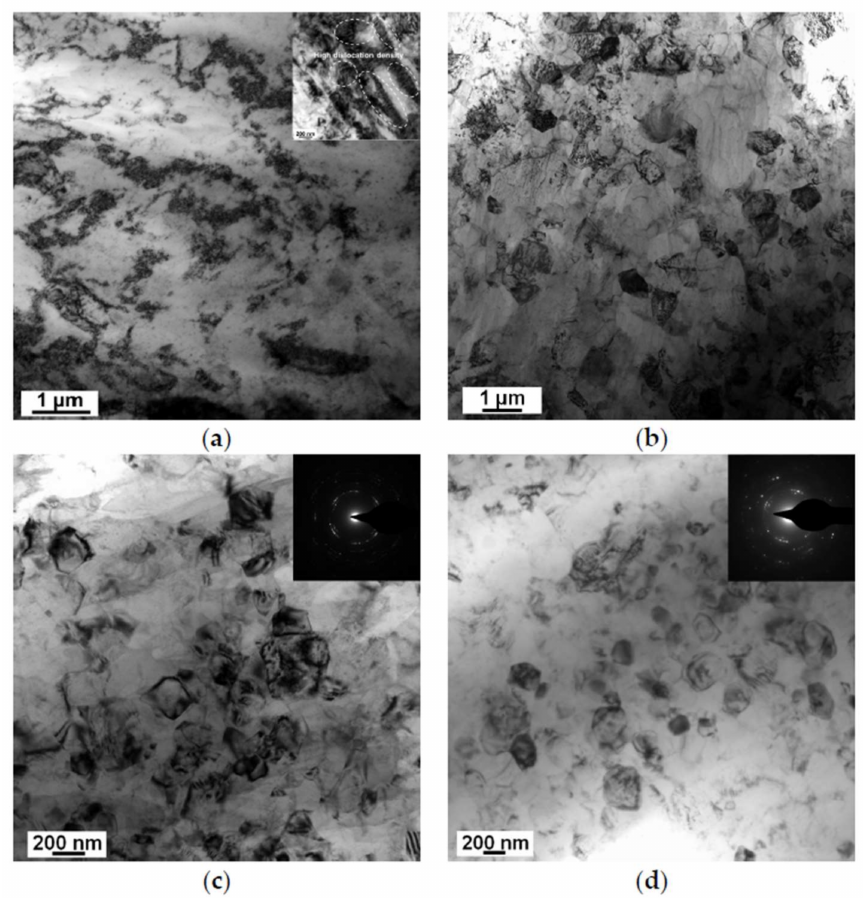
Figure 4. TEM images of LZ91 alloy after HPT processing with different turns of ( a ) 1/4; ( b ) 1; ( c ) 5; and ( d ) 10 at the one-half radius position.